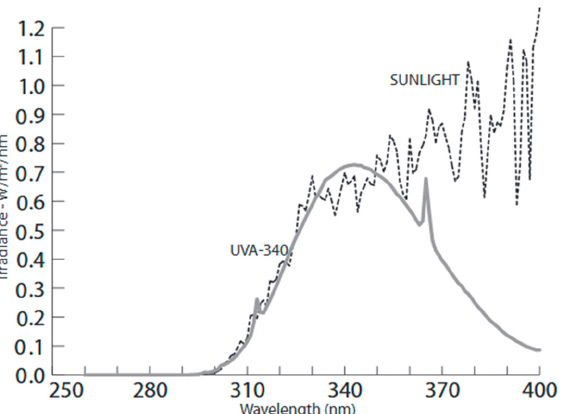
Figure 2. The spectral irradiance emitted by the employed UVA lamps, as compared to that of sunlight assessed on a clear day at solar noon. During cultivation, supplementary light wave- lengths below 320 nm (i.e., UVB) were blocked by wrapping the lamps with a specific polyester filter. In excluded UVA plots, plants received solar light, by which UVA was excluded by using a specific filter. Filters were mounted on steel frames. The roof of the frame struc- ture (parallel to the soil) was covered by the filter, whereas the four sides (perpendicu- larly to the soil) were not covered to ensure air circulation. Transparent polycarbonate sheets were employed as filters, showing no transmission below 400 nm. Over each plot, the frame structure was erected in the north–south direction (having a 26° slope towards the south). At the south-face front, a 0.5 m distance from the soil was considered, while at the north-face front the respective distance was 1.2 m. These frame orientation and di- the